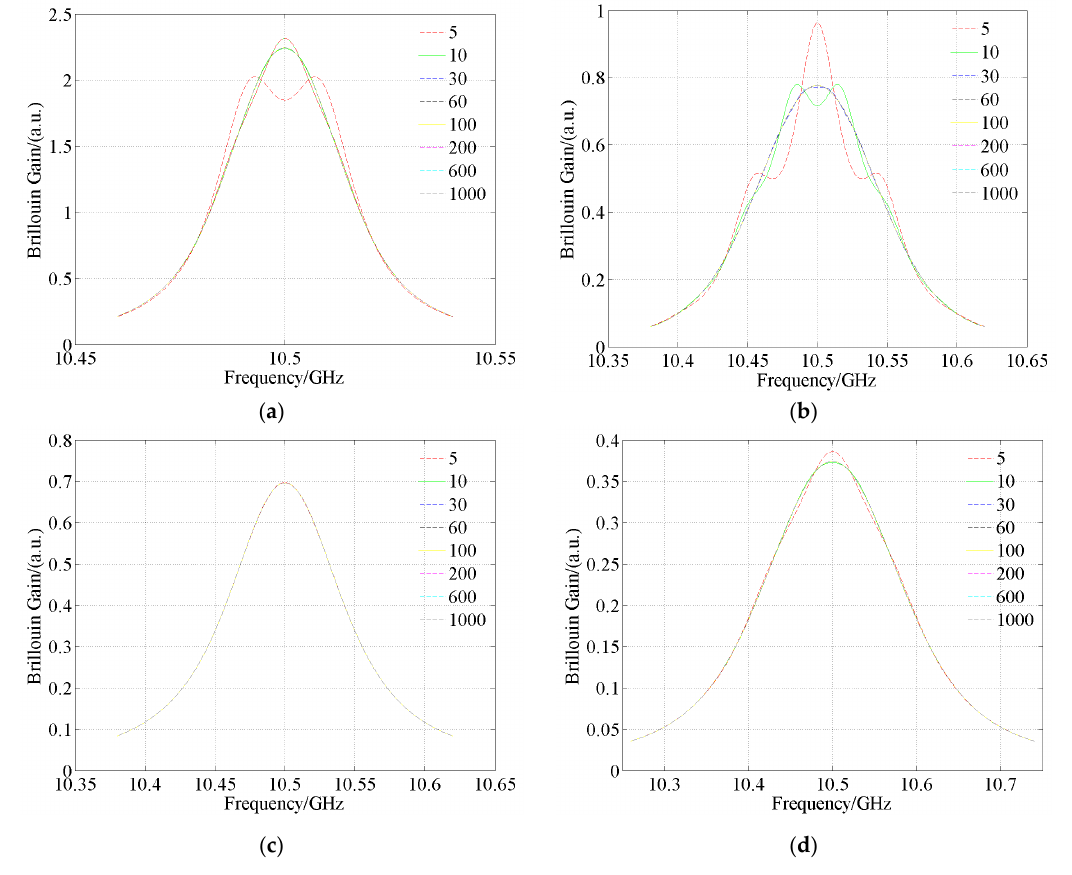
Figure 3. Four typical Voigt waveshapes numerically generated by Gauss-Hermite quadrature with different numbers of sample points. ( a ) Δ v BL = 0.02 GHz, Δ v BG = 0.02 GHz; ( b ) Δ v BL = 0.04 GHz, Δ v BG = 0.08 GHz; ( c ) Δ v BL = 0.08 GHz, Δ v BG = 0.04 GHz; ( d ) Δ v BL = 0.12 GHz, Δ v BG = 0.12 GHz.